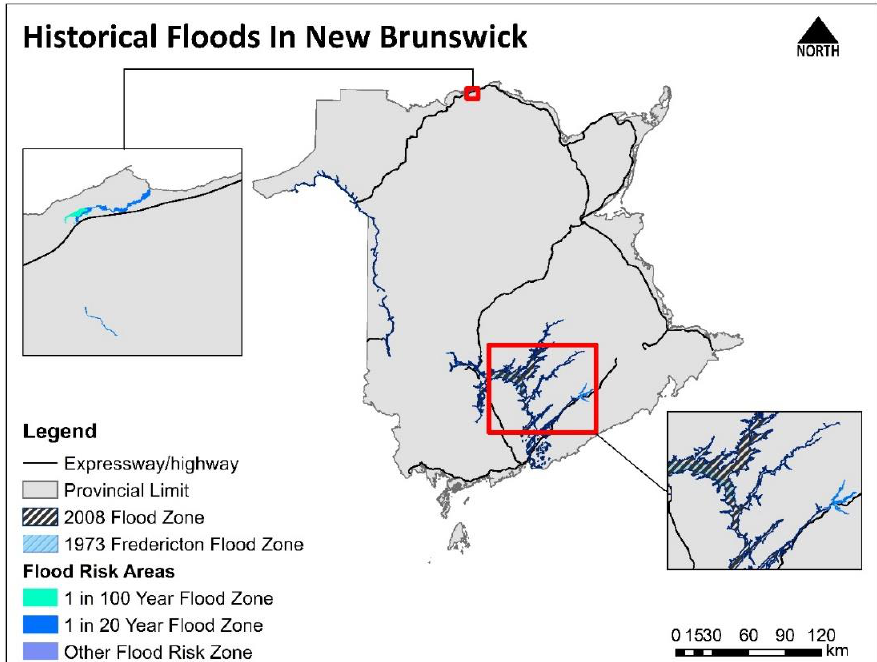
Figure 9. Historical floods in New Brunswick. Adapted from GeoNB [33].